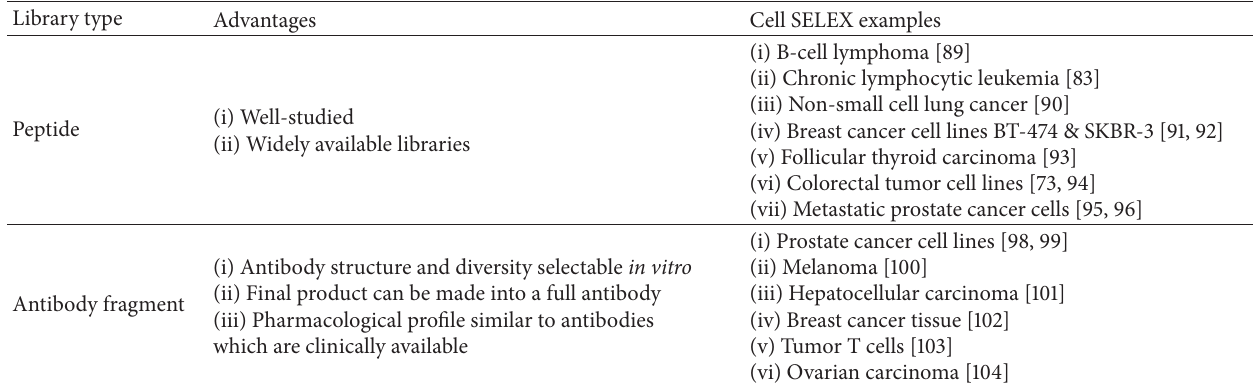
Table 1: Types of amino acid libraries.